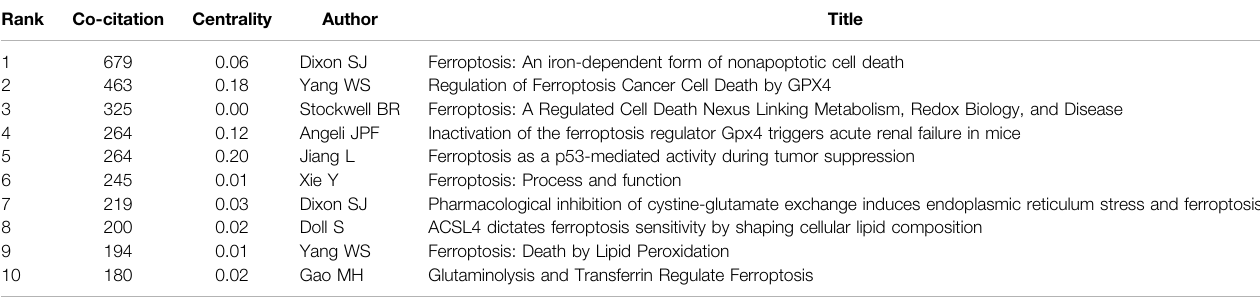
TABLE 5 | Top 10 co-cited references in ferroptosis in cancer research.